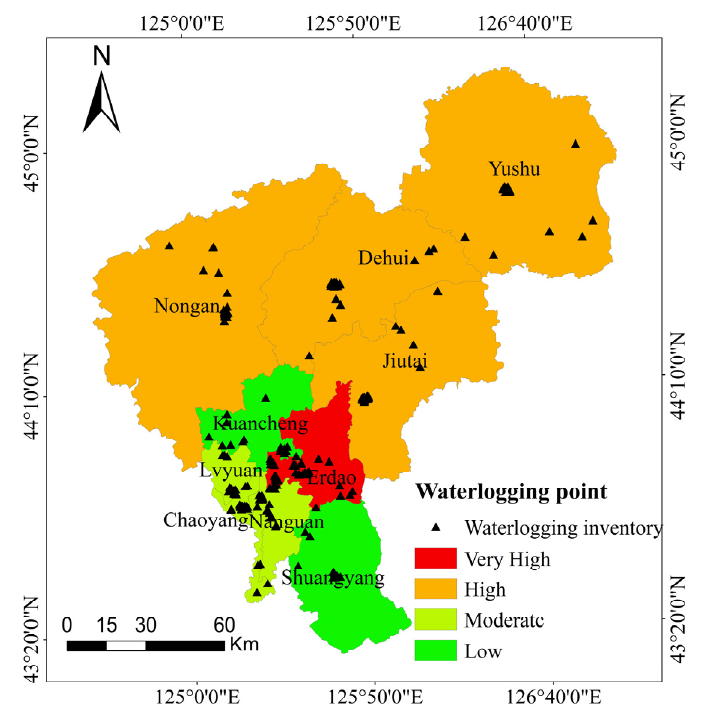
Figure 7. Waterlogging point veri fi cation map.